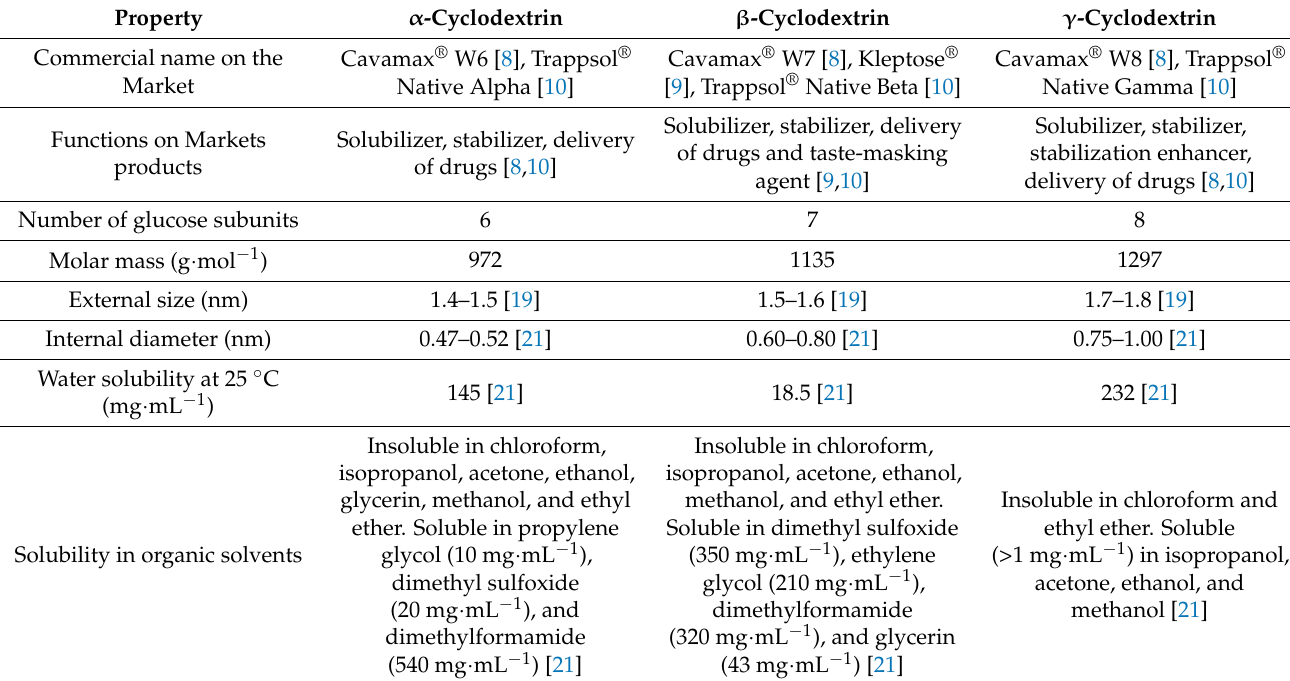
Table 1. Main properties of α -, β -, and γ